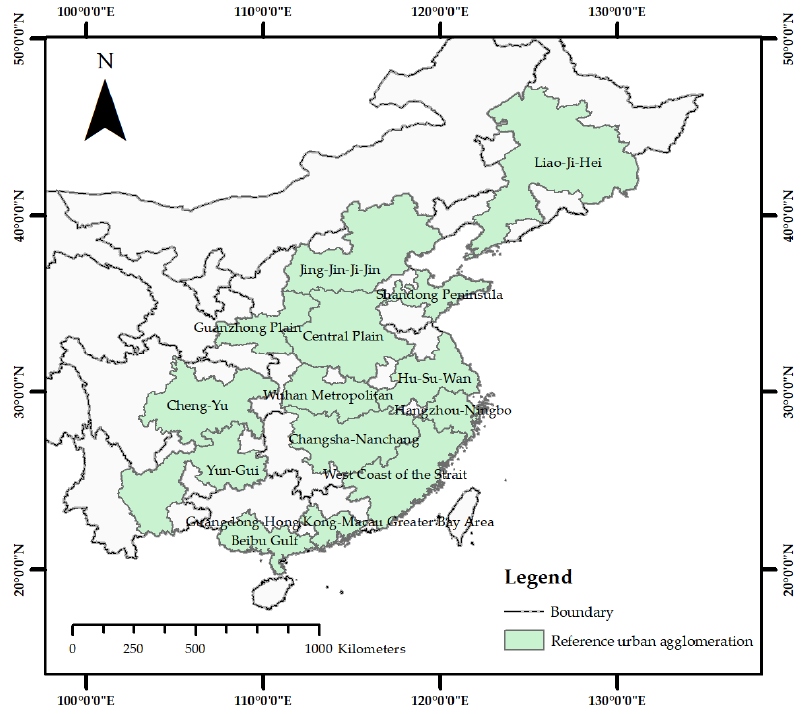
Figure 2. The boundaries of reference urban agglomerations.